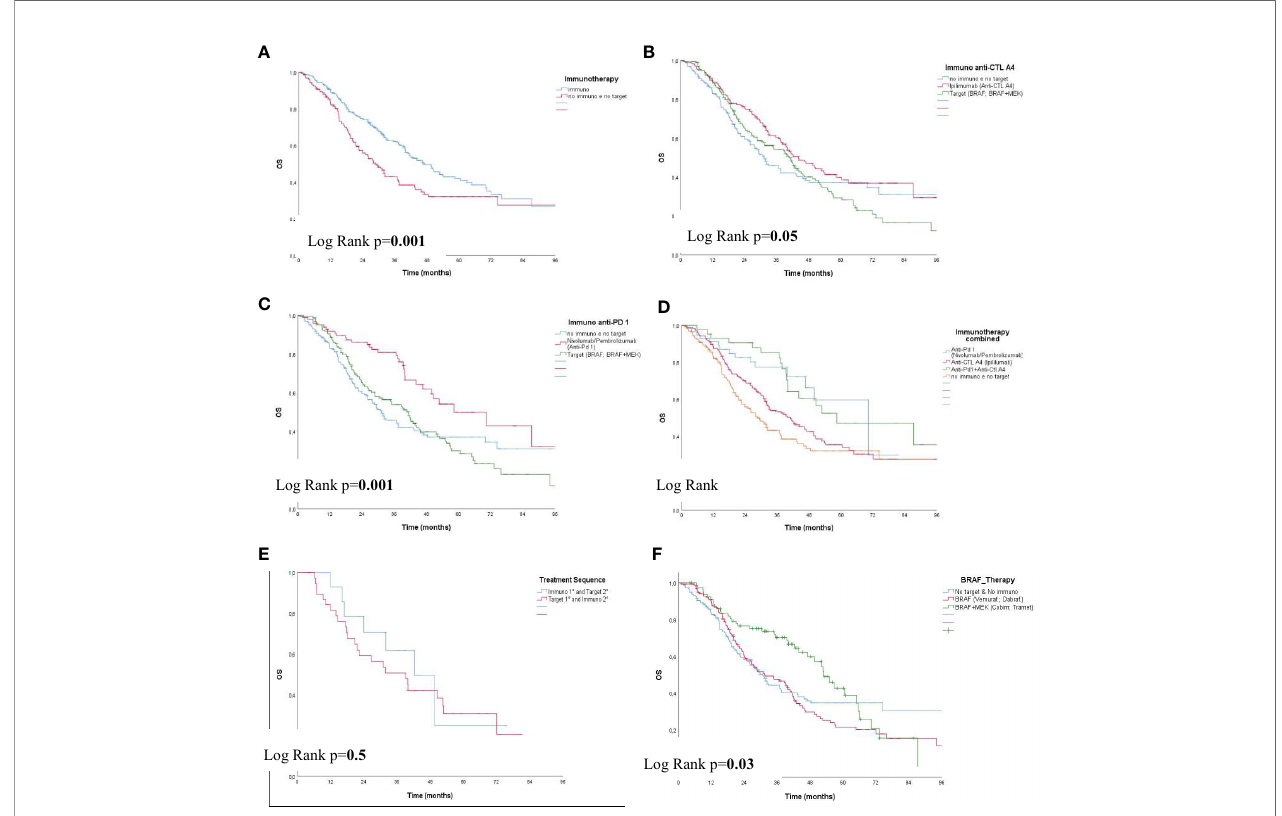
FIGURE 2 | Overall Survival (OS) in patients with IIIB-IIIC (UNRESECTABLE), IV by Therapy (A – F) . (A) Overall Survival (OS) Immunotherapy, (B) OS Immunotherapy: ANTI-CTL A4, (C) OS Immuno: ANTI-PD 1, (D) OS Immuno: ANTI-PD 1; ANTI-CTLA4; ANTI PD 1+ANTI-CTL A4, (E) OS Treatment Sequence:Immuno 1st, 2nd; Target 1st, 2nd; Target 1st & Immuno 2nd (F) OS BRAF vs.